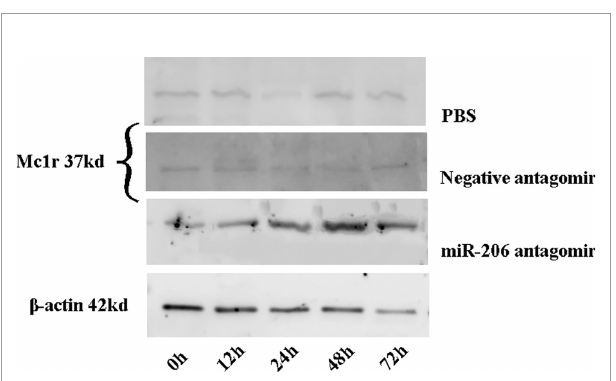
FIGURE 5 | The Mc1r protein content of skin tissues in koi carp at each sampling time point was detected by western blot. b -actin was used as the internal control to quantify the change of Mc1r.